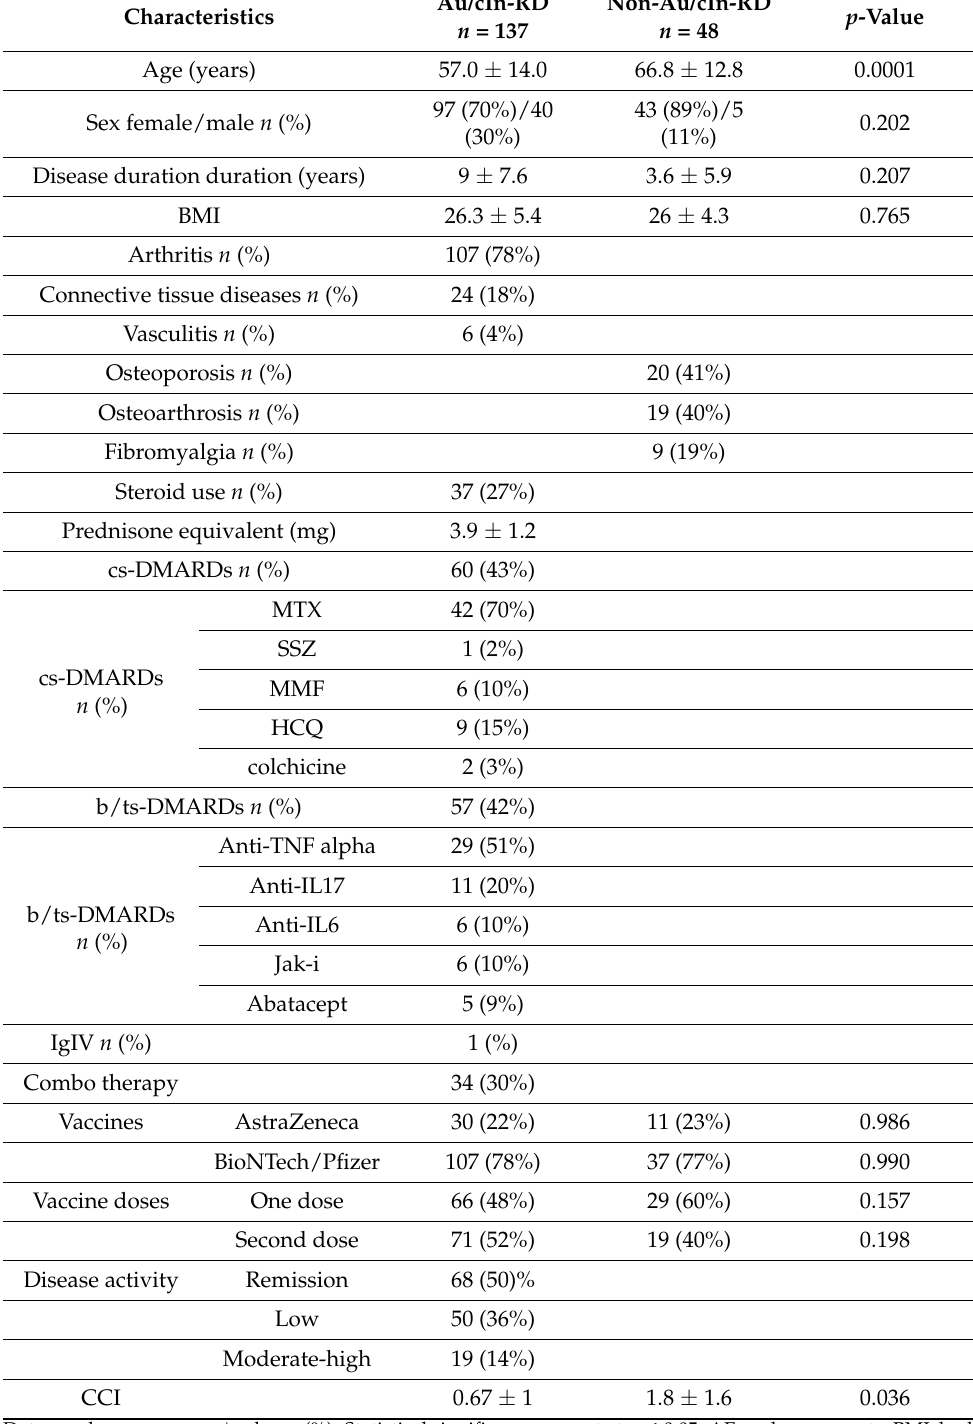
Table 1. Comparison of demographic and clinical characteristics between patients with autoim- mune/chronic inflammatory rheumatic diseases (Au/cIn-RD) and those with nonautoimmune/non chronic inflammatory rheumatic diseases